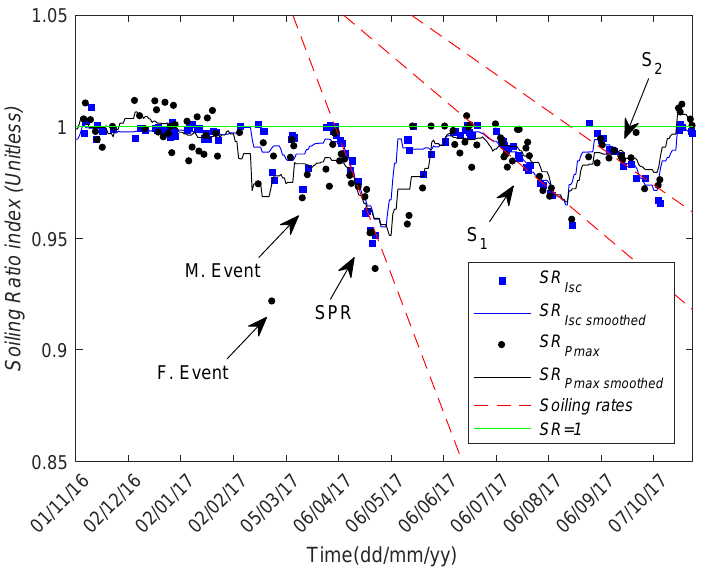
Figure 3. Soiling ratio and